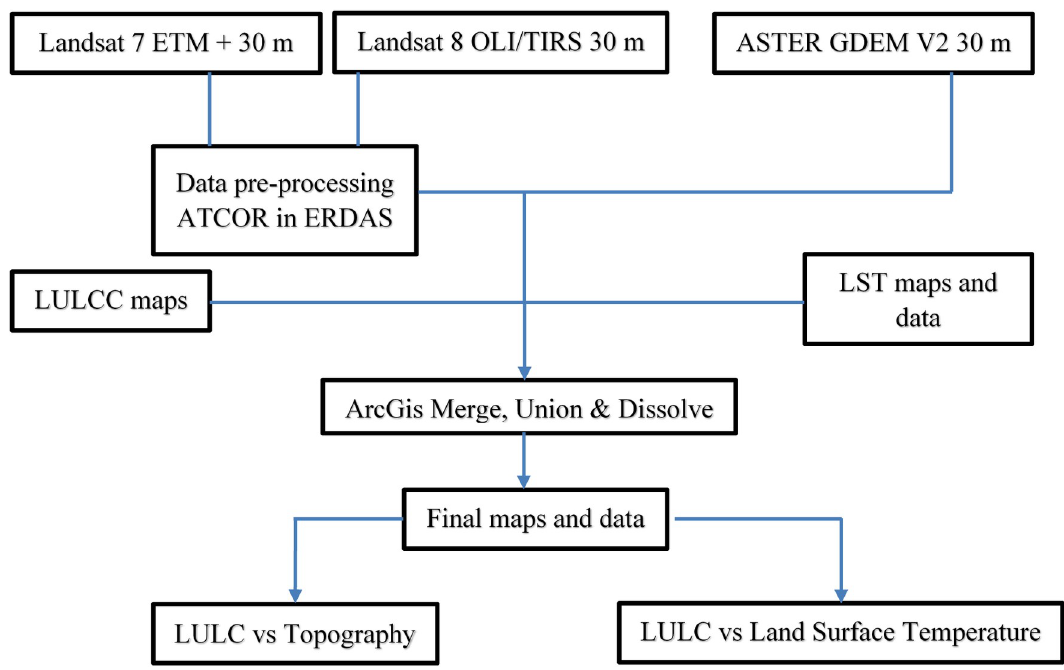
Fig 2. Flowchart outline of the study